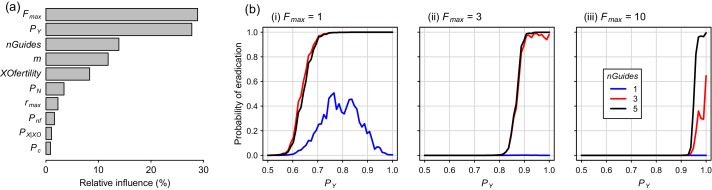
Boosted regression tree (BRT) summary of the sensitivity analysis for the Y-CHOPE gene drive.(a) Relative influence of the ten simulation parameters included in the sensitivity analysis (parameter abbreviations are provided in Table 1). (b) Predicted probabilities of eradication derived from the BRT model for three different levels of polygyny ranging from a maximum of one to 10 females mates per male (i-iii). These partial dependency plots assume the following seven less influential parameters were set as follows: m = 6, XOfertility = 0.6, Pn = 0.1, rmax = 7.76, Pnf = 0.66, nGuides = 3, PX|XO = 0.66, and PC = 0.95.